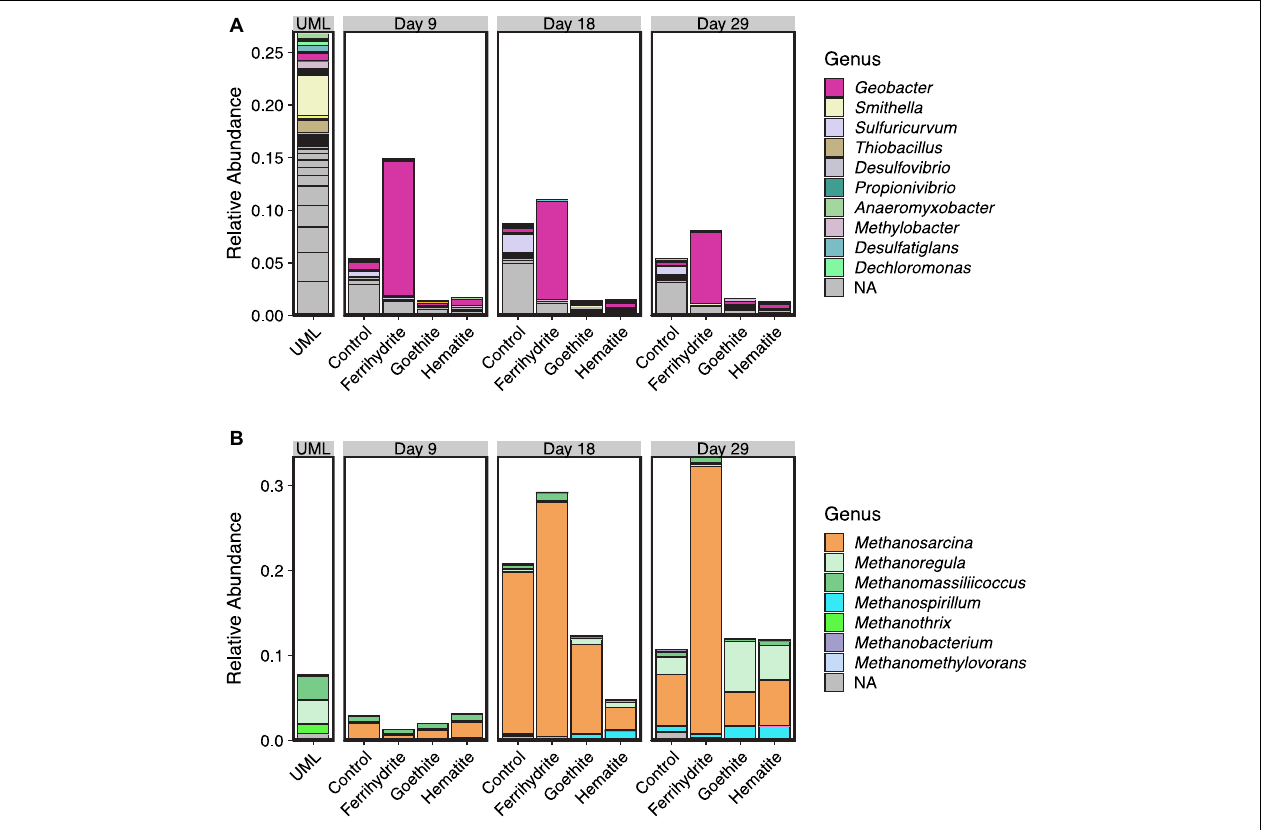
FIGURE 5 | Relative abundance plots of 16s-rRNA data by genera for the phyla Proteobacteria (A) and Euryarcheota (B) . Genera are listed in order from most to least abundant (sum total across all samples) and only genera with a mean relative abundance of 0.001 or greater are included in the legend. Gray bars represent ASVs that could not be classified at the genus level, with breaks within gray bars reprsenting multiple ASVs. Each bar is the average of three experimental replicates. Upper Mystic Lake (UML) sediment data is shown for